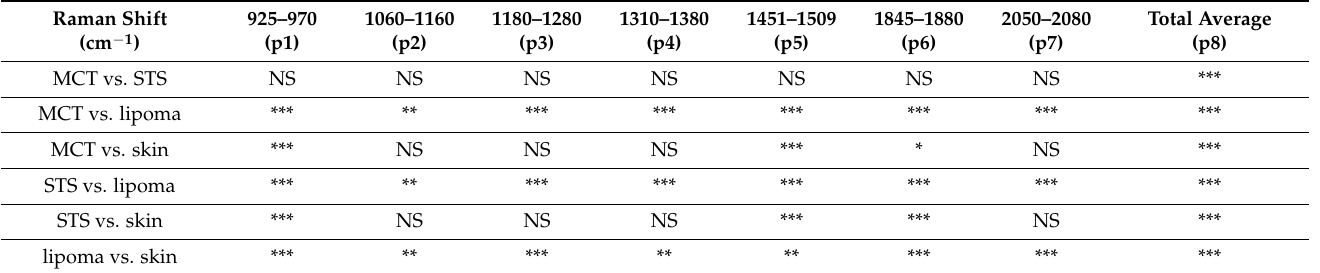
Table 1. Significance between average Raman spectral band intensity values (***, **, *—significant, NS—nonsignificant).